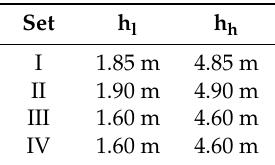
Table 5. Adopted height difference between the trajectory and catenary wires’ lower boundary (h l ) and upper boundary (h h ).